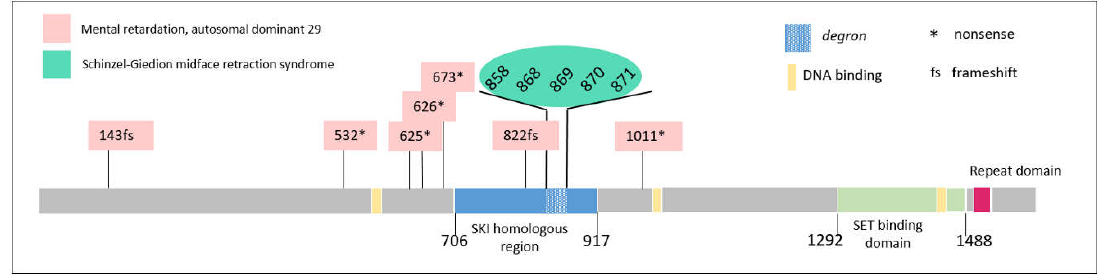
Figure 5. Structure of SETBP1 and sites of pathogenic mutations associated with Schinzel-Giedion syndrome and mental retardation.